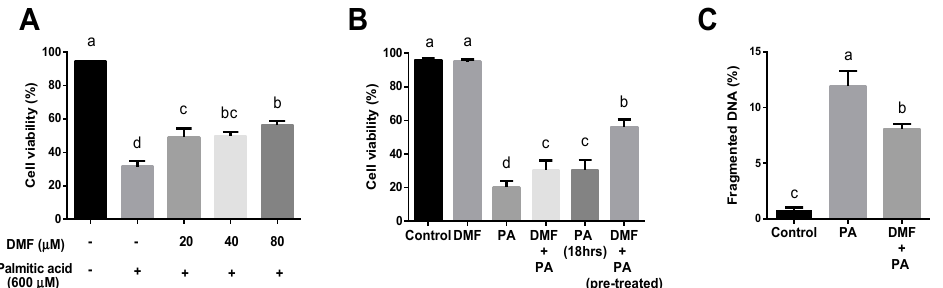
Figure 2. The effect of DMF pretreatment on PA-induced lipotoxicity. Cell death was measured by membrane permeability to PI using flow cytometry analysis in ( A ) AML12 treated with 600 µ M palmitic acid (PA) and increasing concentrations of dimethyl fumarate (DMF) for 24 h (10,000 cells, n = 3). ( B ) AML12 treated with 40 µ m DMF for 6 h before 0.6 mM PA (pretreated) or simultaneously for 24 h (10,000 cells, n = 3). ( C ) DNA fragmentation was evaluated using Flow cytometry analysis in AML12 treated with 40 µ M DMF for 6 h before 600 µ M PA. Means with different letters are statistically different ( p < 0.05).